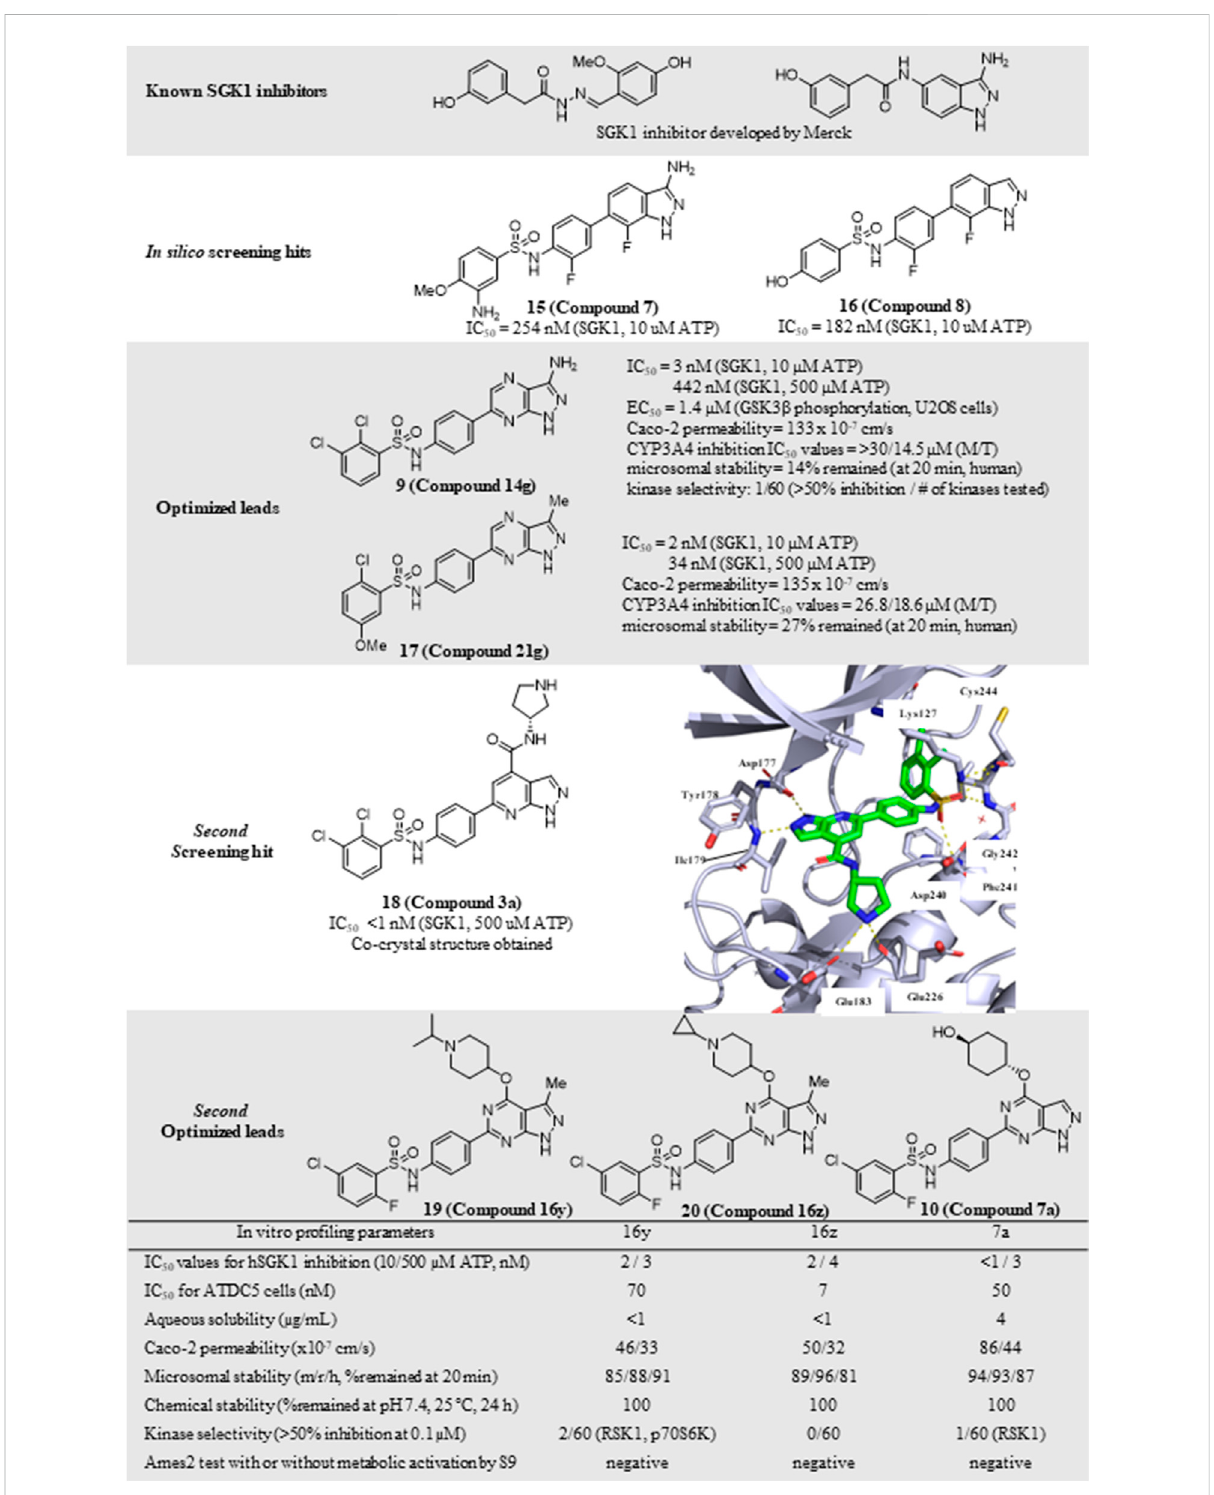
FIGURE 4 Discovery of N -(4-(1 H -pyrazolo[3,4- d ]pyrimidin-6-yl)phenyl)-5-chloro-2- fl uorobenzenesulfonamides as an SGK1 inhibitor. SGK1, serum and glucocorticoid-regulated kinase